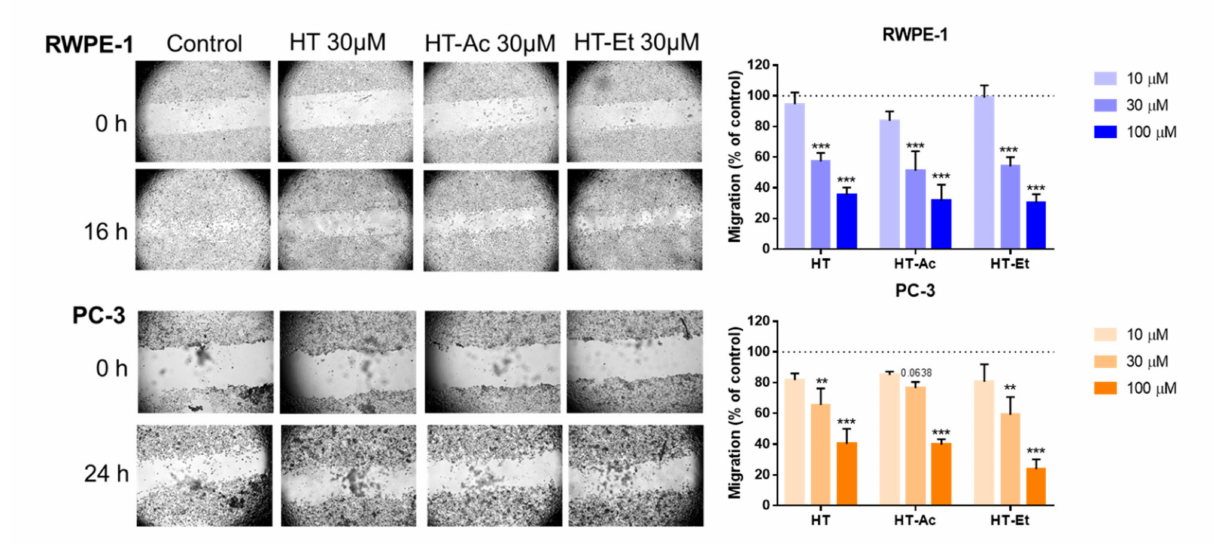
Figure 3. Cell migration rate of RWPE-1 (16 h), and PC-3 (24 h) treated with 0–100 µ M of HT, HT-Ac, and HT-Et. The micrographs (magnification 40 × ) illustrate representative captures of the RWPE-1 and PC-3 cells before and after treatment with vehicle (DMSO, control) or 30 µ M of HT and derivatives. Data are expressed as migration (percent of control, set at 100%) and represent the mean ± SEM (4 experiments). Asterisks indicate significant differences to DMSO control, set at 100% and represented as a dashed line: ** p < 0.01, *** p < 0.001. Abbreviations: HT, Hydroxytyrosol; HT-Ac, hydroxytyrosyl acetate; HT-Et, ethyl hydroxytyrosyl